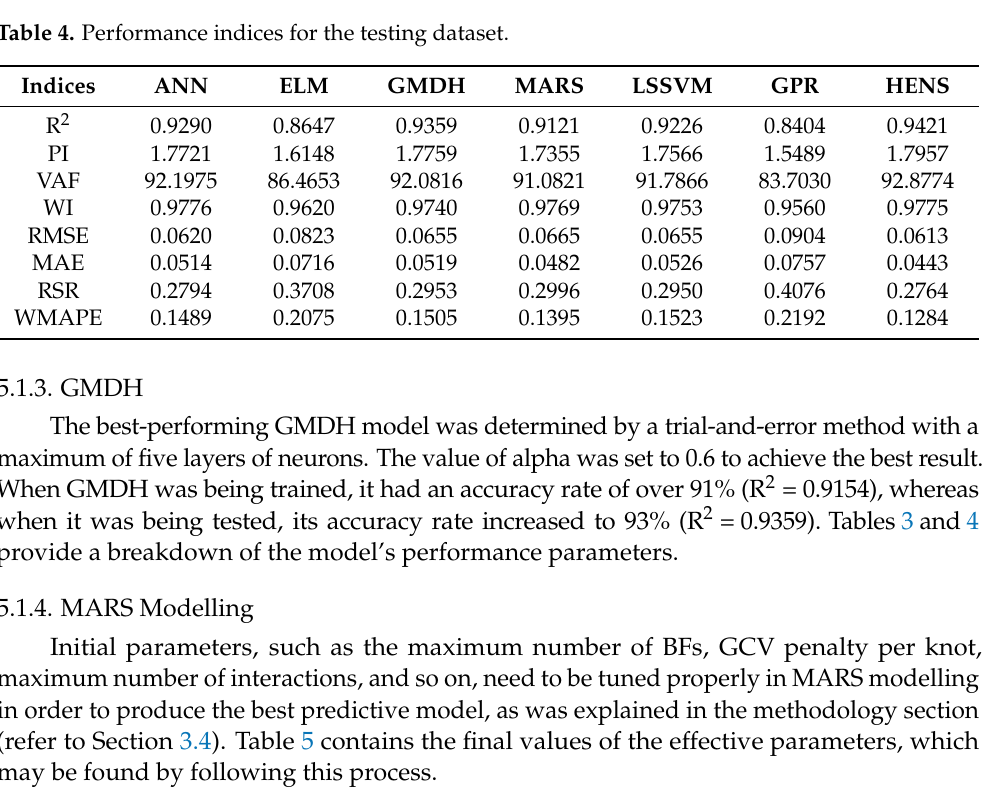
Table 5. Basis function of the MARS